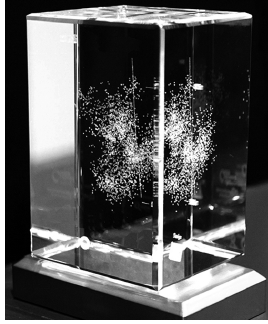
Figure 13. The well known 1st handed down photography (from approx. 1826) of Joseph Nicéphore Niépce, the inventor of photography, showing the pigeon roof through a window of his house in Saint-Loup-de-Varenne (France) (retouche initiated by Gernsheim (1965)) Lasered crystals already became part of our daily life and might mark the first step of an expected booming progress in advanced 3D Visualization (not only) of Cultural Heritage.